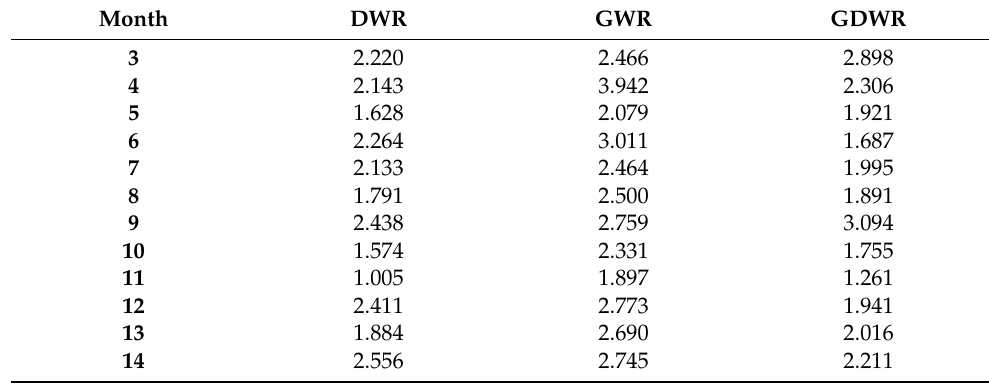
Table 1. Comparison of F 2 test results.